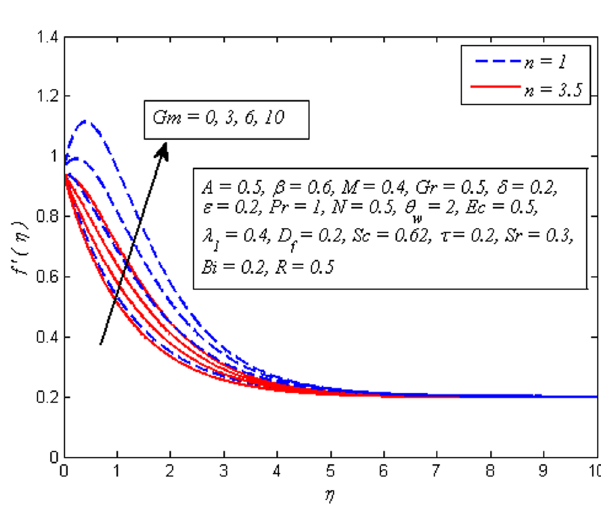
Figure 6. Effect of Gr on velocity for various values of n .